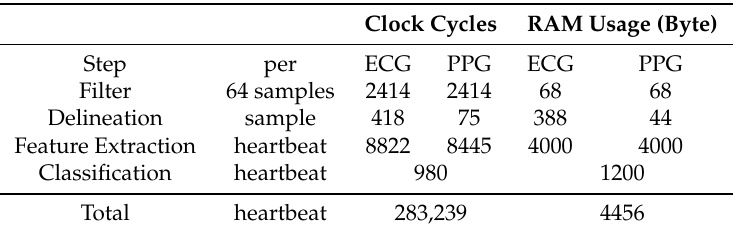
Table 7. The EB detection algorithm is implemented on the TI MSP432 MCU. Clock cycles and RAM usage are measured for every step of the algorithm. The results are given for a sample rate of 500 Hz and a heart rate of 72 beats per minute (bpm). For the calculation of the total values, the distributed nature of the algorithm is taken into